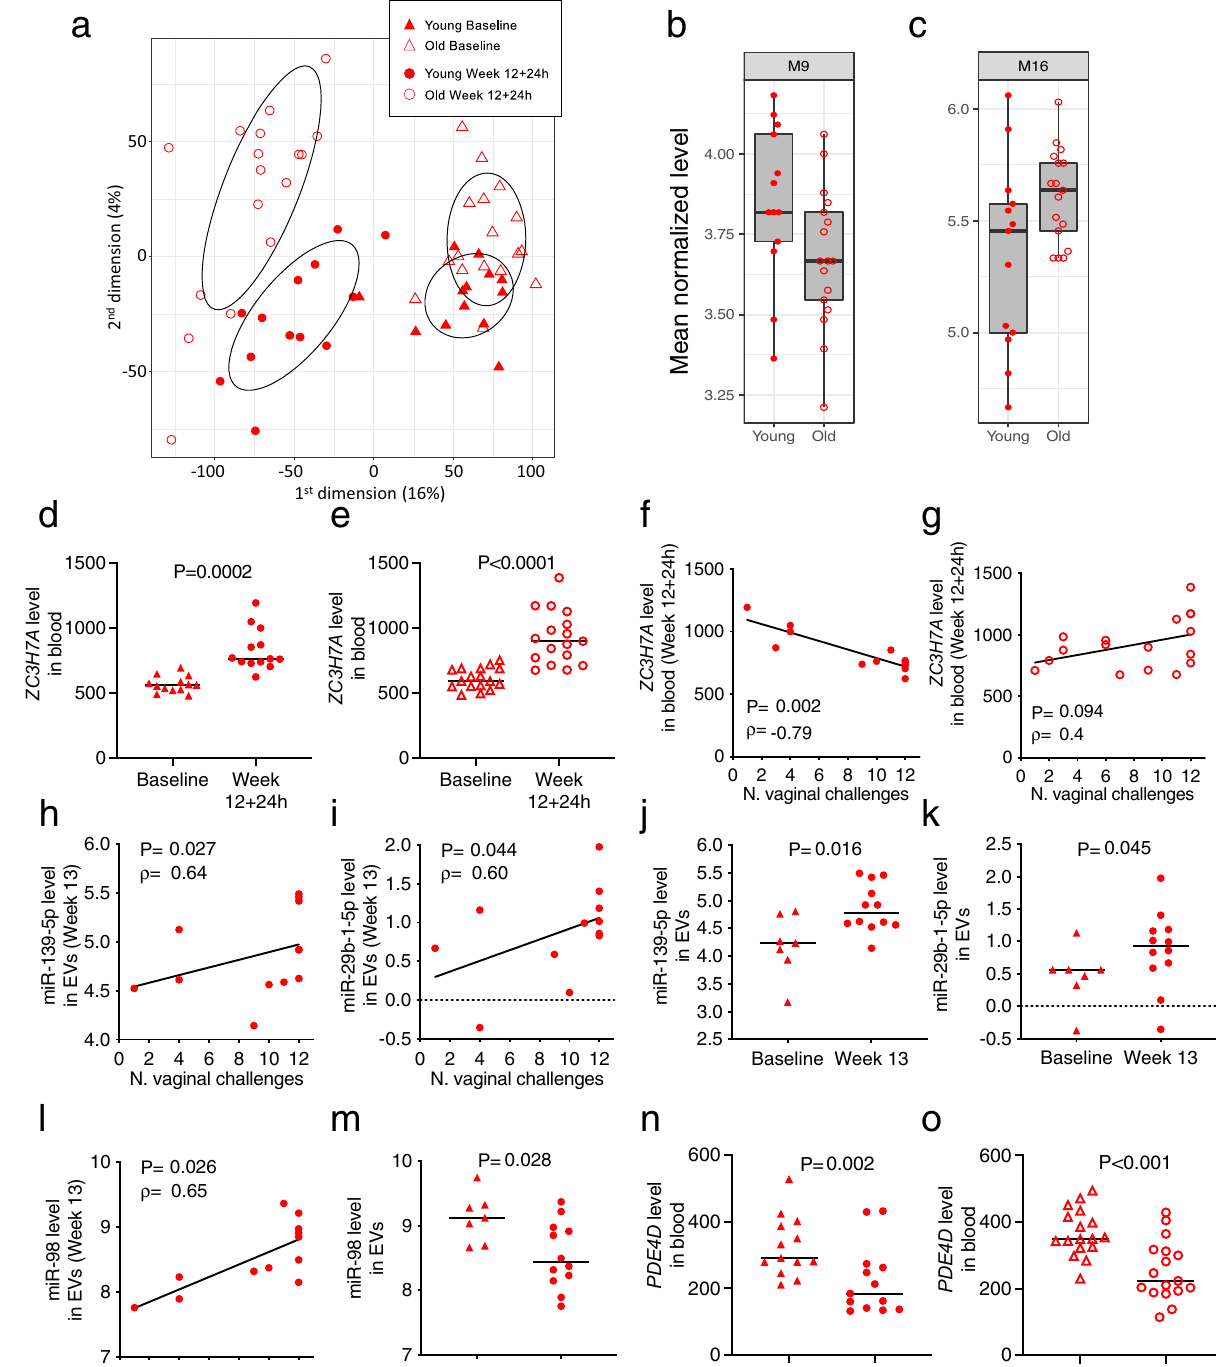
Fig. 2 | Transcriptome and extracellular vesicular microRNAs. a Multidimensionalscalingplotsummarizinggeneexpression.Differentresponses to vaccination identi fi ed in n =13 young and n =17 old animals. Differences were presentbetweenbaselineand24hfollowingvaccination( fi rstdimension,Wilcoxon test, p =3.18×10 − 11 ) and between young and old groups (second dimension, Mann – Whitney, p =8.77×10 − 6 ). b , c Expression levels of genes in BioAge modules